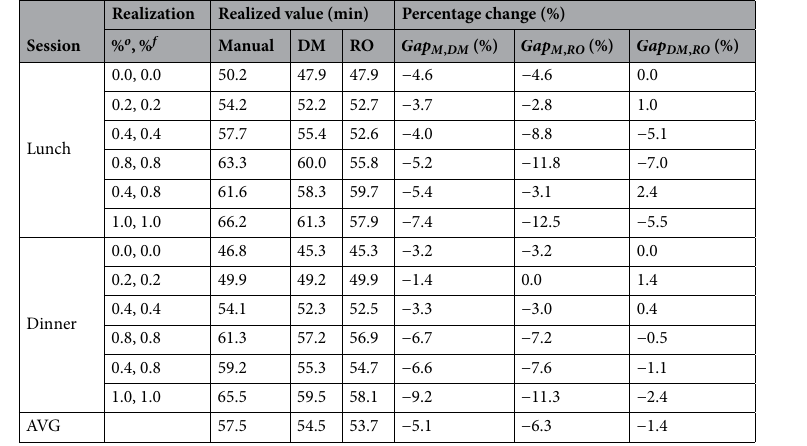
Table 4. Average realized value with perturbation set ( ˆ µ o = 80, ˆ µ f = 160 ) .